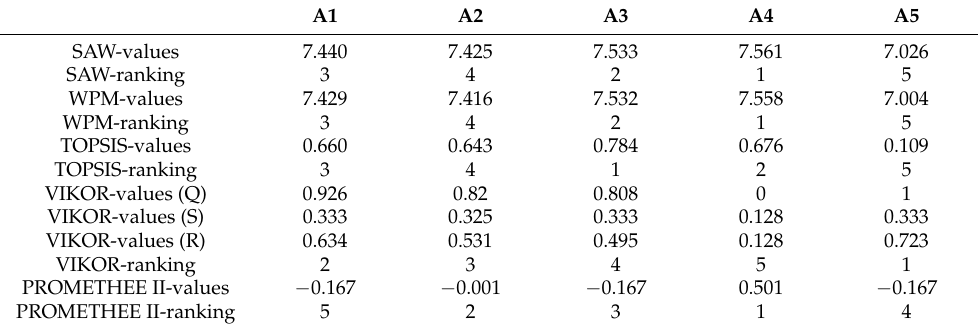
Table 10. The values and ranking of the alternatives using the equal weighting